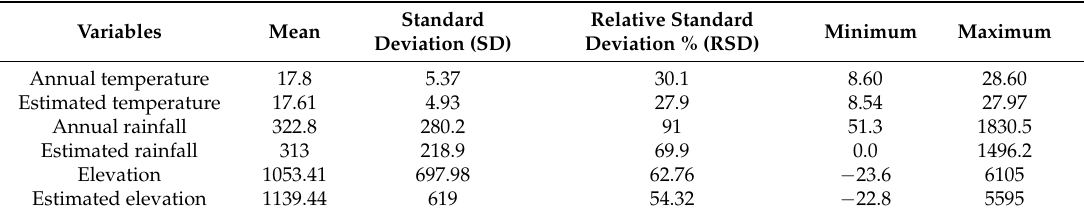
Table 1. Statistical properties of original and estimated